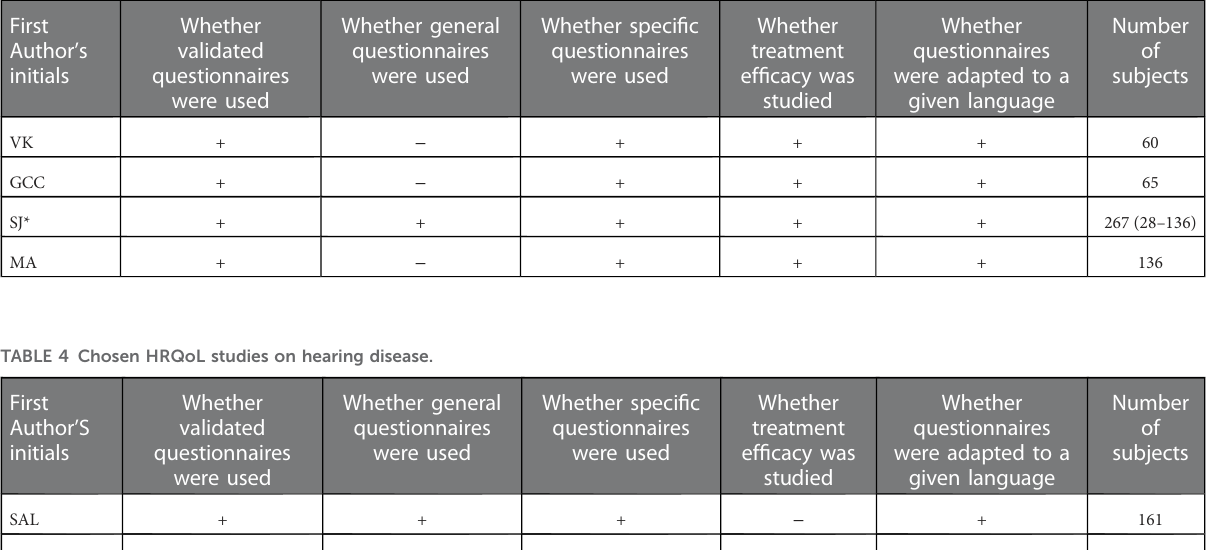
TABLE 3 Chosen HRQoL studies on nasal septum deviation.